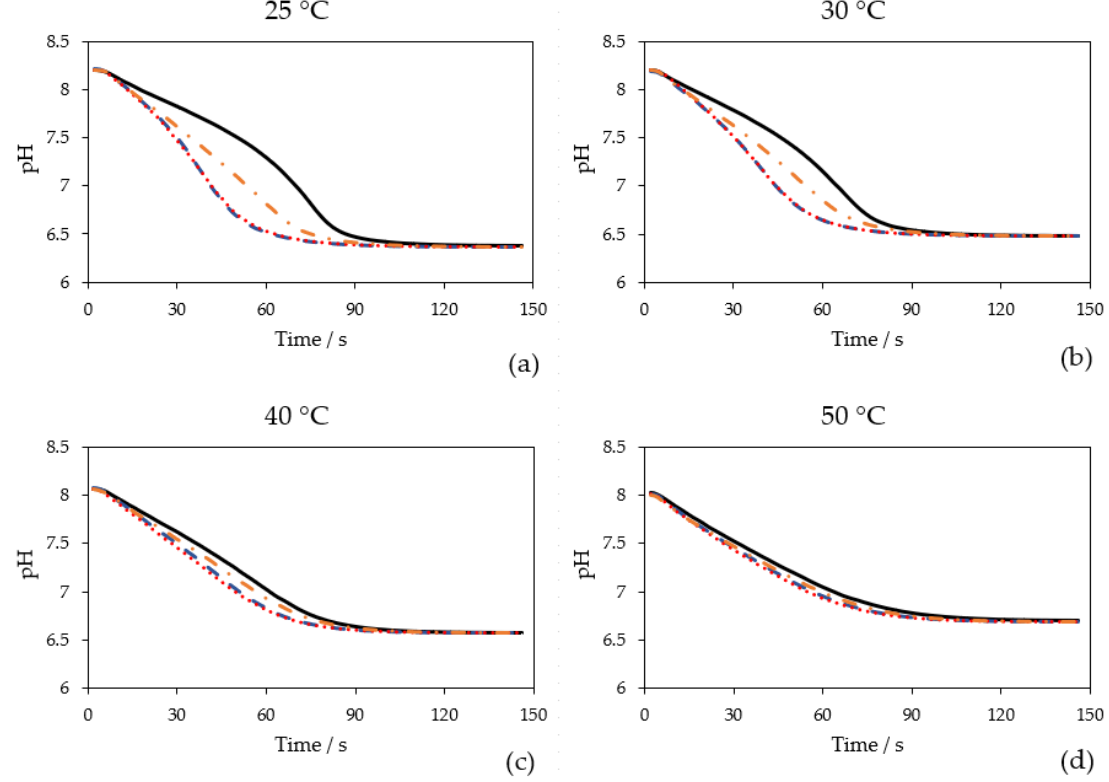
Figure 3. Time-dependent course of pH when 0.1 mol L − 1 Tris-sulfate buffer was sparged with 100% CO 2 (200 mL min − 1 ) at different measurement temperatures: ( a ) 25 °C; ( b ) 30 °C; ( c ) 40 °C; ( d ) 50 °C. Without enzyme (black, solid line), with 0.25 mg L − 1 AwCA (blue, dashed line), with 0.25 mg L − 1 PmCA (red, dotted line), with 0.25 mg L − 1 MtaCA (orange, dashed-dotted line). n = 3.